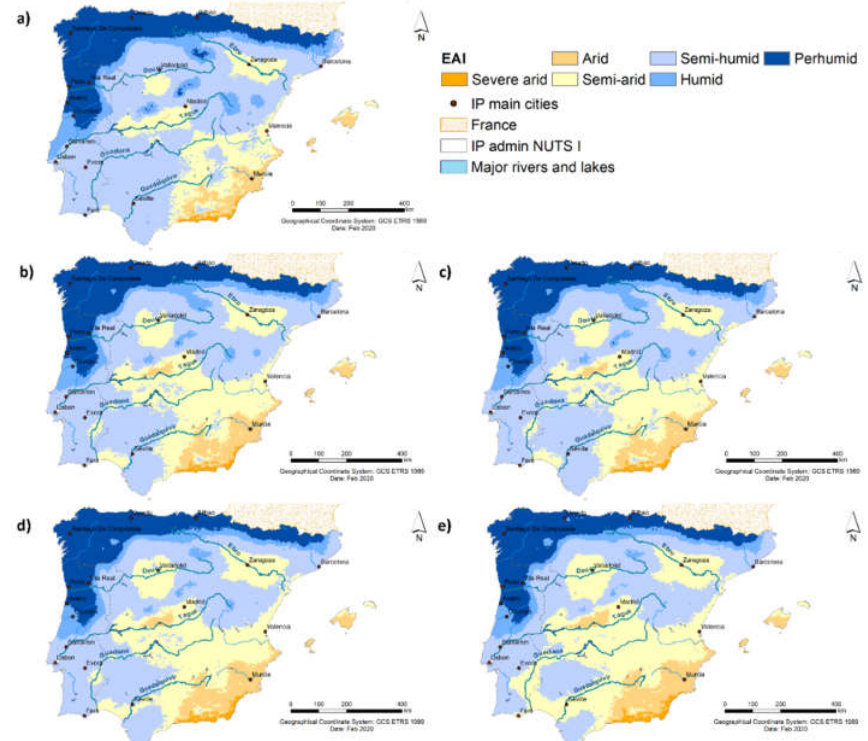
Figure 8. The Erinç Aridity Index (EAI) spatial distribution for the Iberian Peninsula for the period ( a ) 1961–1990, ( b , c ) 2011–2040, and ( d , e ) 2041–2070 under RCP4.5 ( left ) and RCP8.5 ( right ) scenarios.